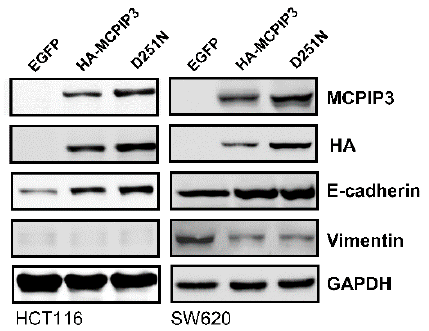
Figure 7. Effects of MCPIP3 and MCPIP3-D251N mutant overexpression on epithelial–mesenchymal transition (EMT)-related protein expressions in human HCT116 and SW620 colorectal cancer cells. HCT116 and SW620 cells were transduced with a lentiviral vector (at an MOI of 3) expressing the indicated enhanced green fluorescent protein (EGFP), HA-MCPIP3, and HA-MCPIP3-D251N mutant and then cultured for 24 h. Total proteins were collected to determine protein expressions by a Western blot analysis.